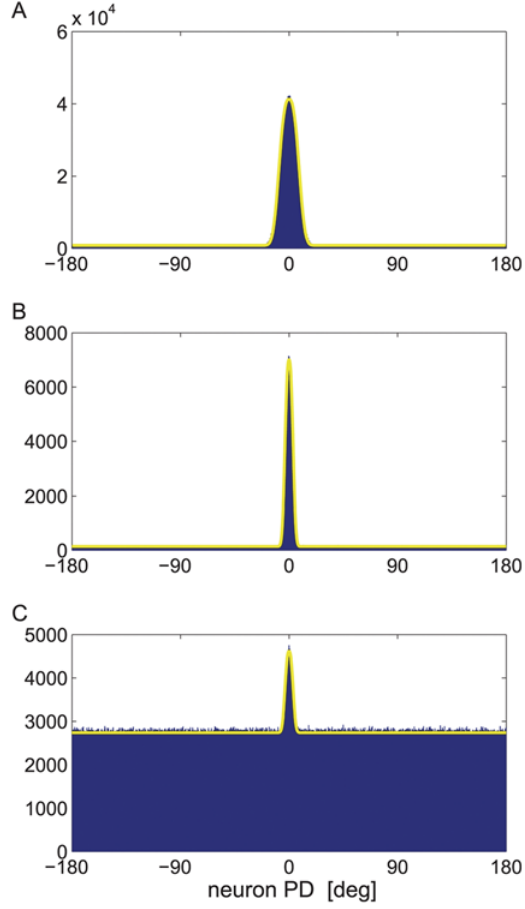
Figure 10. Effect of baseline firing on the tWTA estimation in a hypercolumn model. Histograms of tWTA estimation of stimulus h ~ 0 were obtained in a model of delayed step function response to the stimulus, equation (36), with t h ð Þ ~ t 1 { cos h ð Þð Þ , and parameters: t ~ 50 ms , r ~ 50 Hz and r o ~ 1 Hz . Population size was N ~ 360 in (a) and N ~ 3600 in (b,c). Histograms were estimated using 10 6 repetitions in (a,b) and using 10 7 repetitions in (c). The solid lines are analytical approximations of equation (37) in (a,b) and equation (38) in